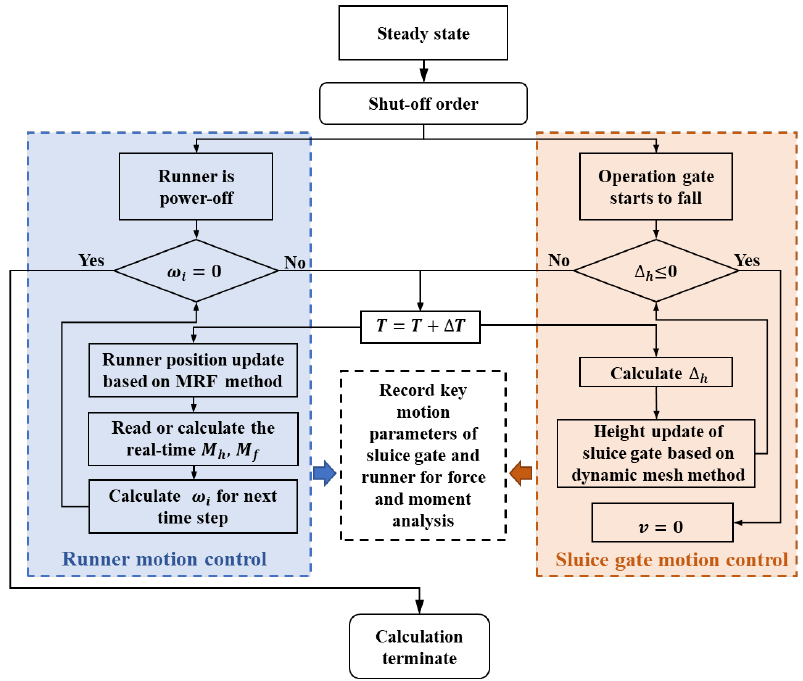
Figure 5. The cooperative control of the runner and SG during the calculation. The left and right sides represent the runner and SG control steps, respectively.